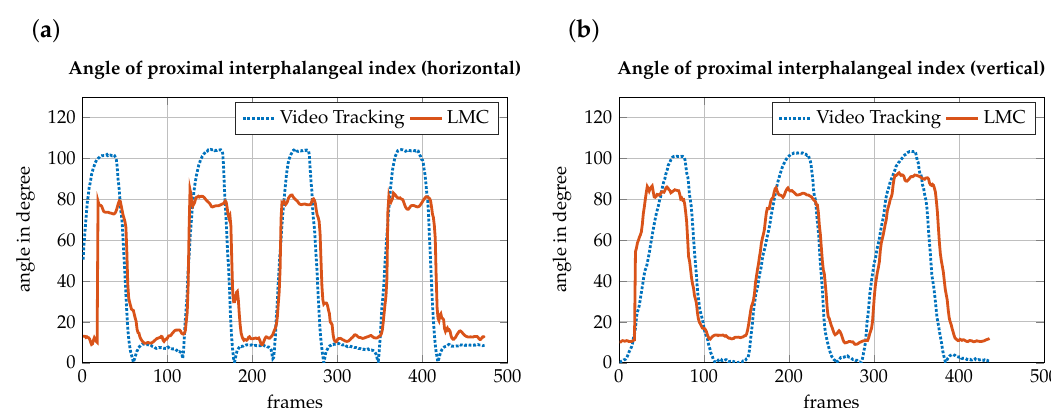
Figure 11. Comparison of the flexion φ PP , IP , angle between the proximal phalanges (PP), and the intermediate phalanges (IP) while forming a fist, recorded by the LMC (red, solid) and the motion tracking of the video camera (blue, dotted). ( a ) The hand is horizontally above the sensor. ( b ) The hand is vertically above the sensor. Because of finger covering, palm covering, and a lack of contrast, the LMC makes a mistake during the recording of a movement in extreme situations (angle > 80